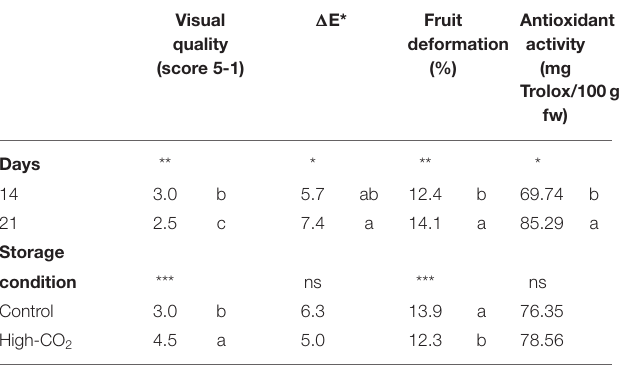
Total sugars were analysed on ethanol extracts by a phenol- sulfuric colourimetric method (19) with colour development at 490 nm and glucose as a